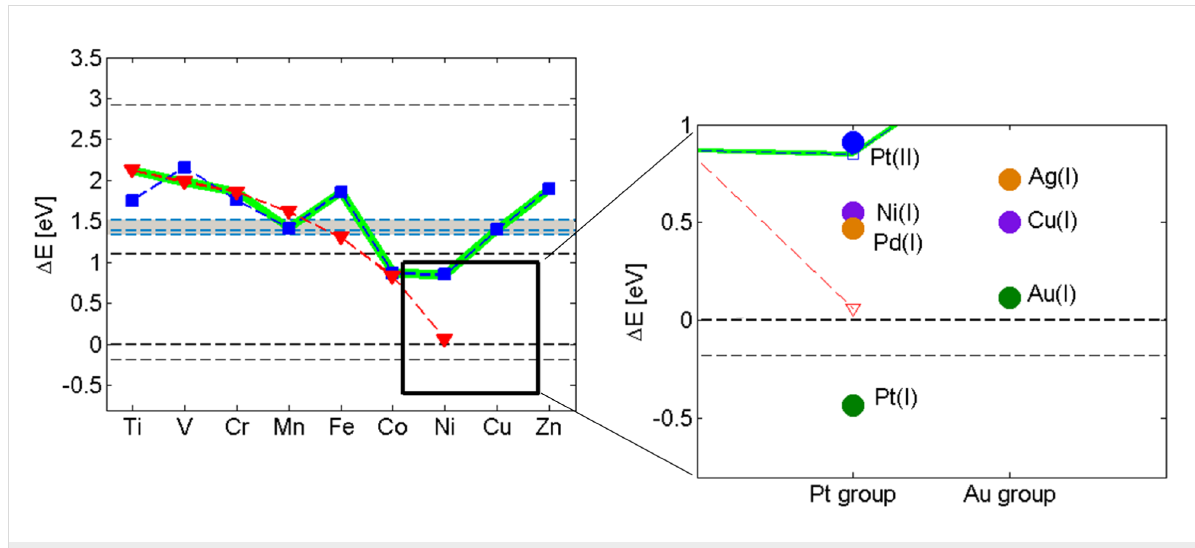
Figure 2: The diagram on the left is identical to Figure 1d. The enlarged region exposes the overpotentials for the elements in the Pt and Au groups. Note that Pt + associated hydride displays a negative overpotential implying that it is more stable than the H 2 (g) asymptote (lower dashed line).